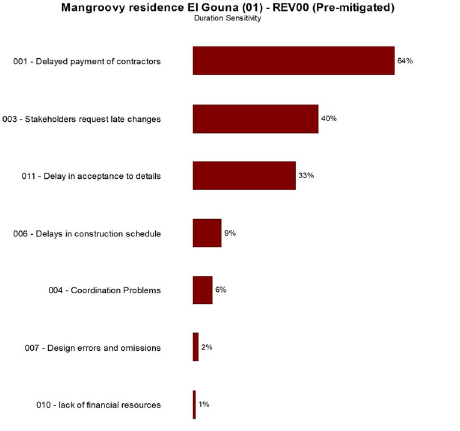
Fig. 10. Sensitivity analysis – duration sensitivity Fig. 10. Alt Text: Sensitivity analysis – duration sensitivity: Subcontractor late payment risk is one of the most significant risks affecting project time with a sensitivity of 64%.